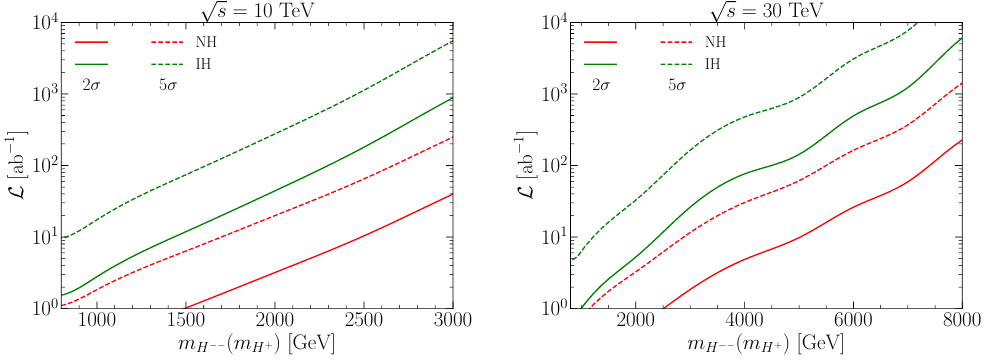
Figure 16 . The integrated luminosities for 2 σ (solid lines) and 5 σ (dashed lines) significance versus for H ±± H ∓ → µ ± µ ± µ + ν at muon collider with m H ±± ( H ∓ ) for NH (red) or IH